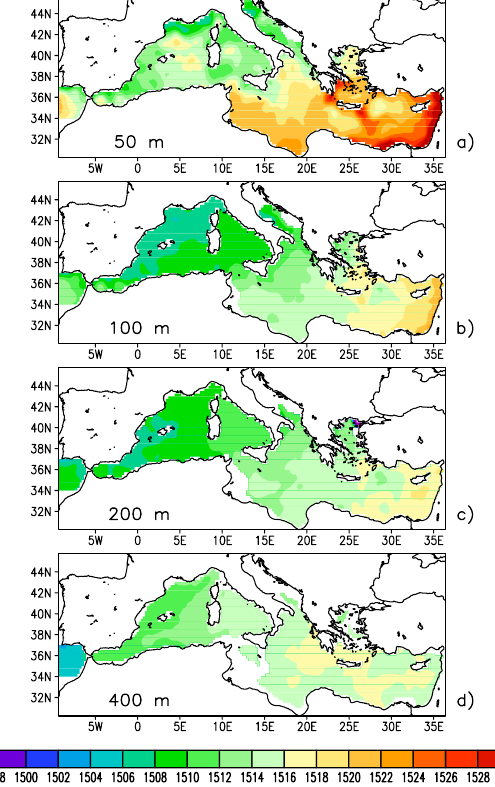
Fig. 5. Sound speed monthly mean (m/s) in February at 50m (a) , 100m (b) , 200m (c) and 400m (d) .